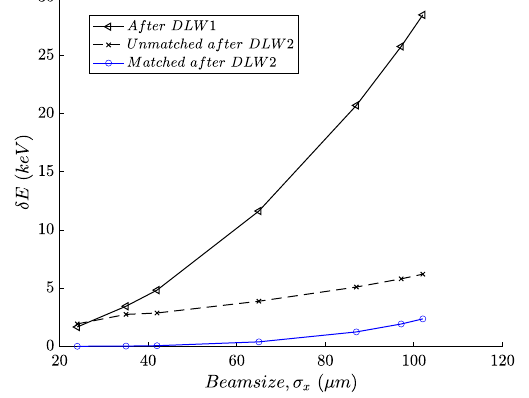
FIG. 9. The transversely correlated energy spread as a function of incoming rms beam size at the entrance of the first DLW. Results are presented at the exit of DLW 1 and at the exit of DLW 2 staging without the increase in beam size due to a drift